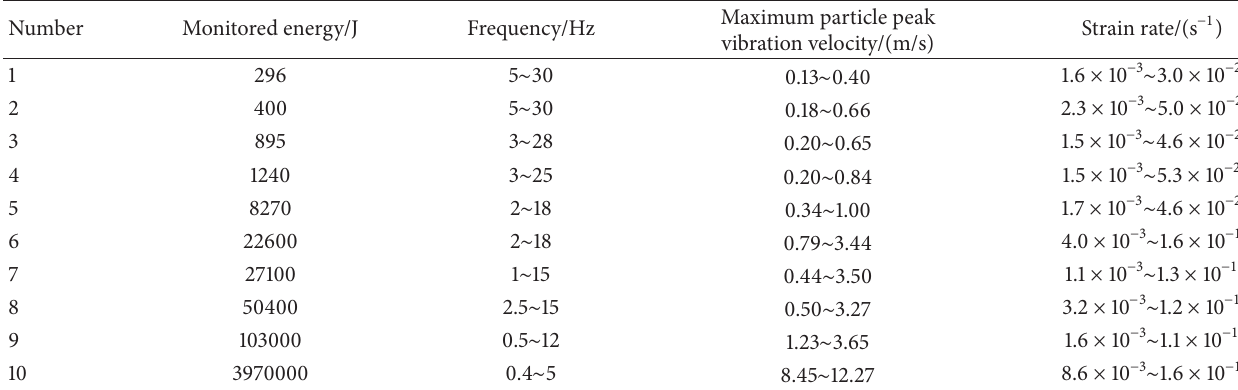
Table 3: Statistics of mining dynamic load strain rate range of mining